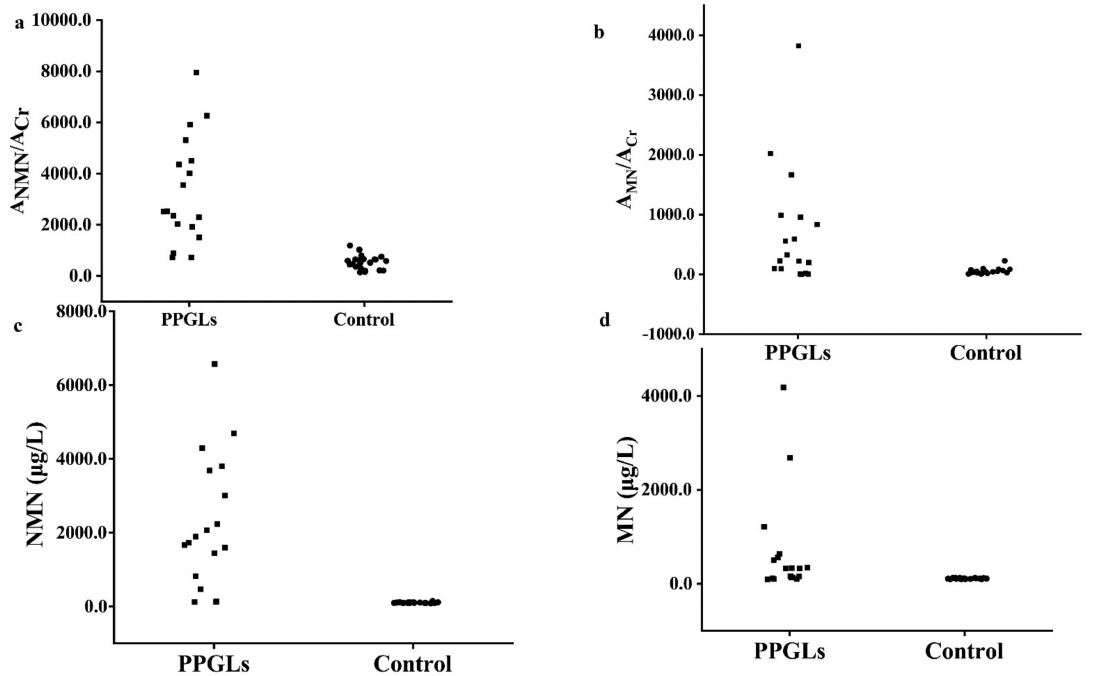
Figure 5. The spot urine A MNs /A Cr results and plasma free MNs results of PPGLs and control (( a ). spot urine A NMN/ A Cr ; ( b ). spot urine A MN/ A Cr ( c ). plasma free NMN ( d ). plasma free